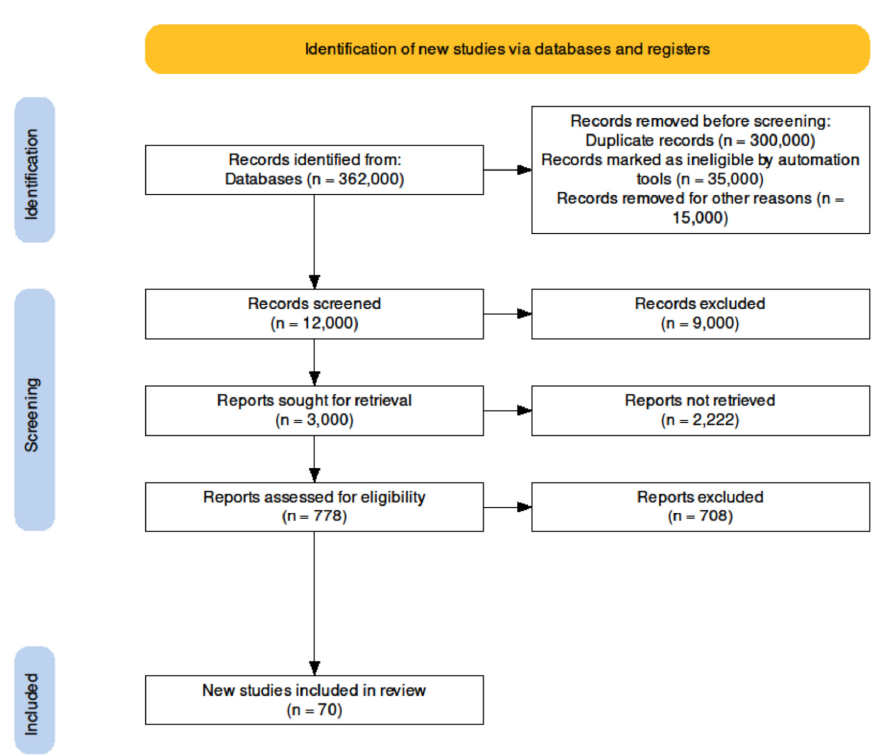
Figure 1. PRISMA flow diagram for the current study .